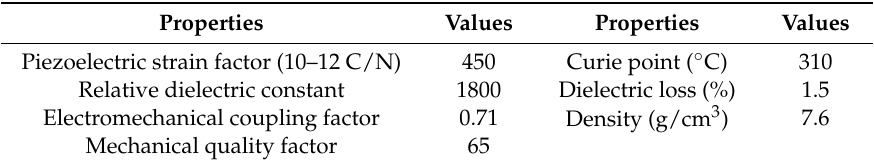
Figure 3. Setup of the testing system of ( a ) impedance method and ( b ) wave propagation method. Table 2. Properties of the PZT sensor.